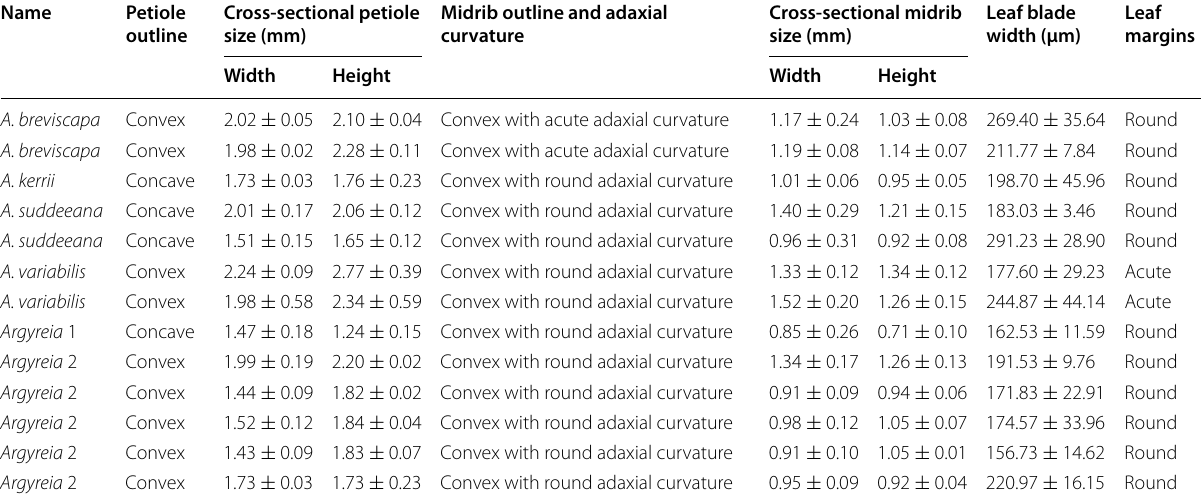
Table 4 Leaf and petiole transverse section characters in summary